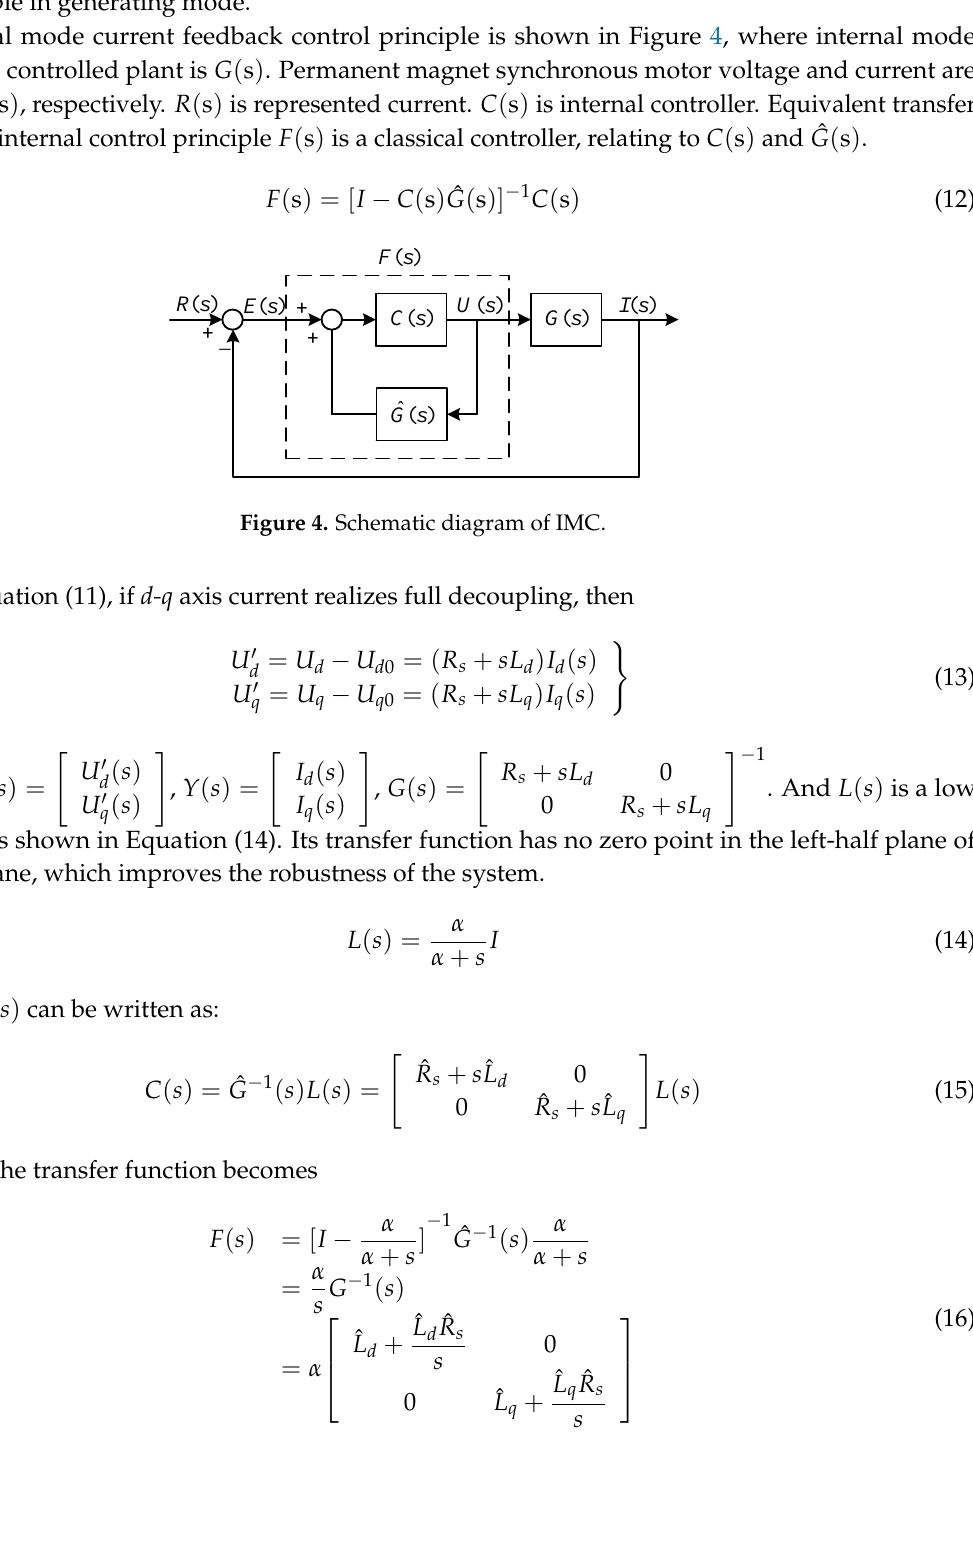
Figure 3. Control strategy based on decoupling of current feedback.